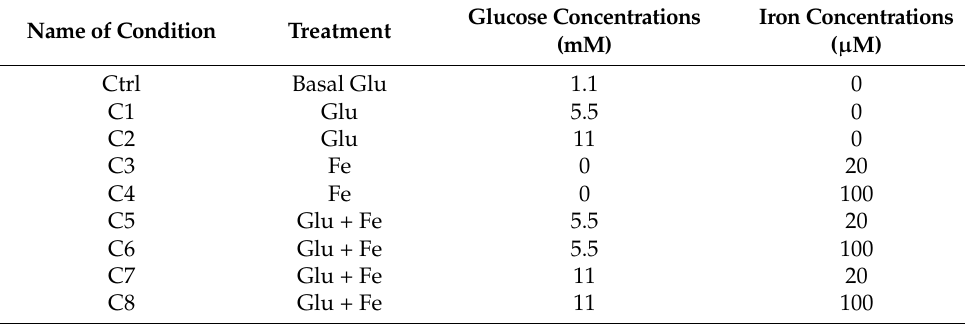
Table 1. Iron and glucose treatment